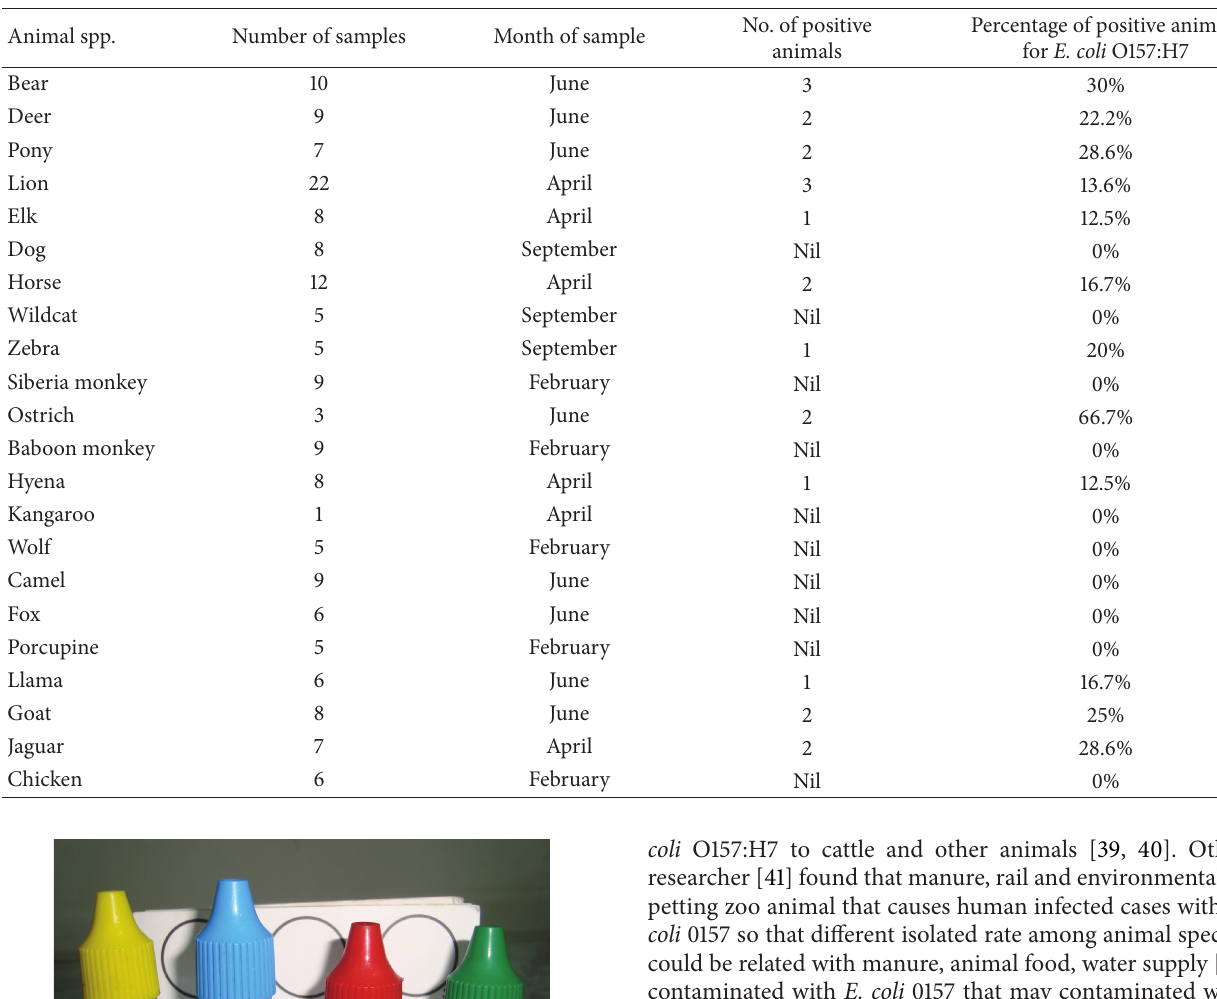
Table 1: Number of positive E. coli O157:H7 animals from fecal samples collected and date of each collection for different animal species in Al-Zawraa zoological society of Baghdad.